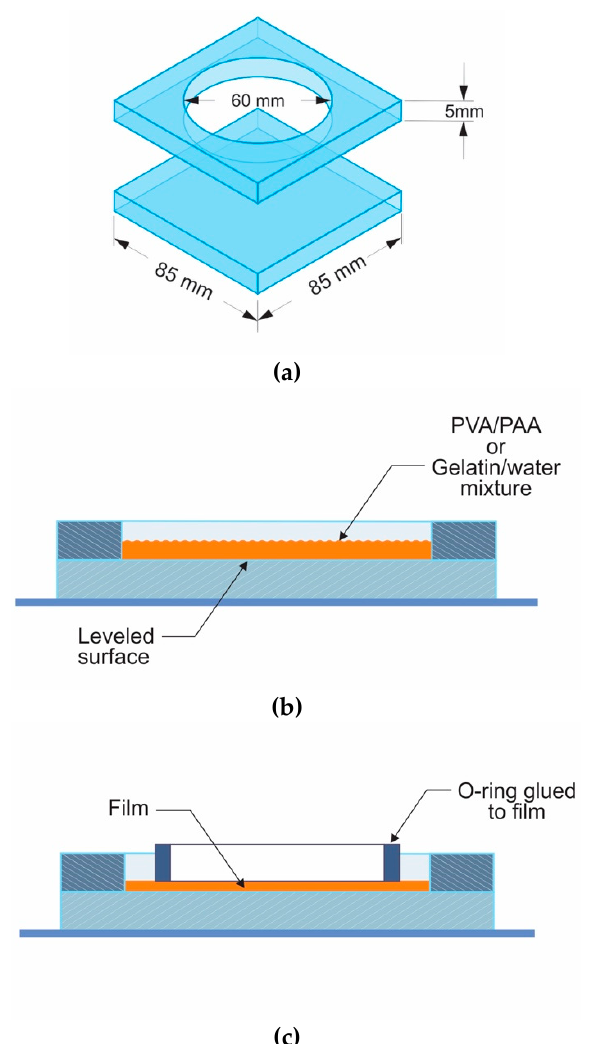
Figure 1. Schematic shows the process to make thin films: ( a ) two glass pieces; ( b ) pouring the mixture and ( c ) gluing the metallic ring.